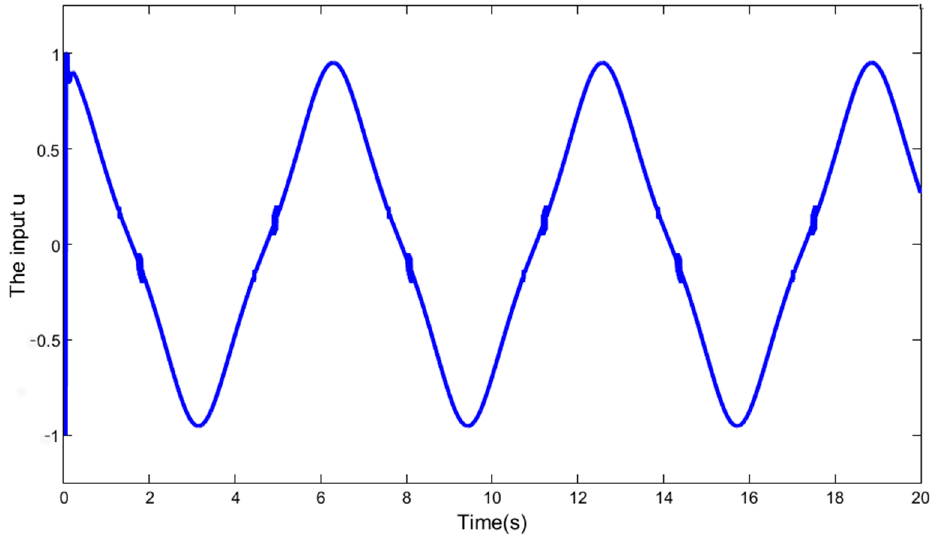
Figure 12. Control input for GSTDO-GSTBSMC u in Experiment 2.